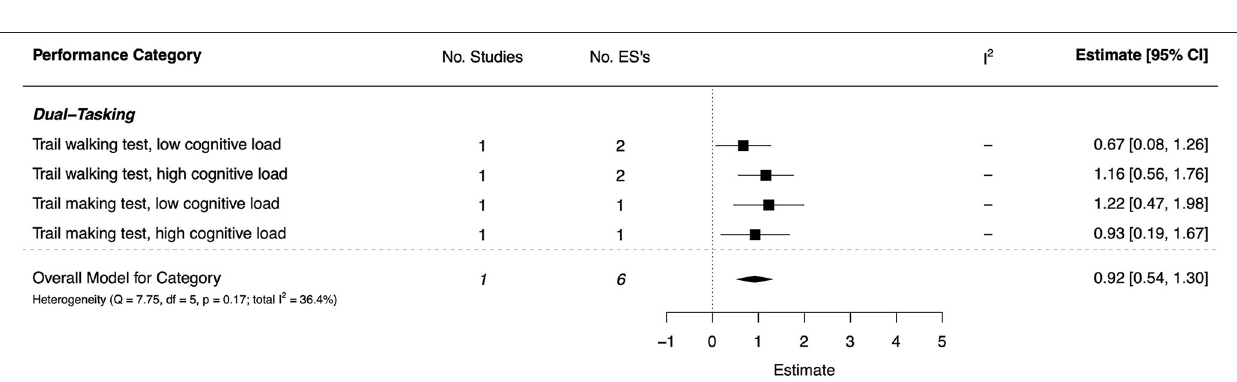
FIGURE 13 | Forest plot showing the meta-analysis results for the dual-tasking performance